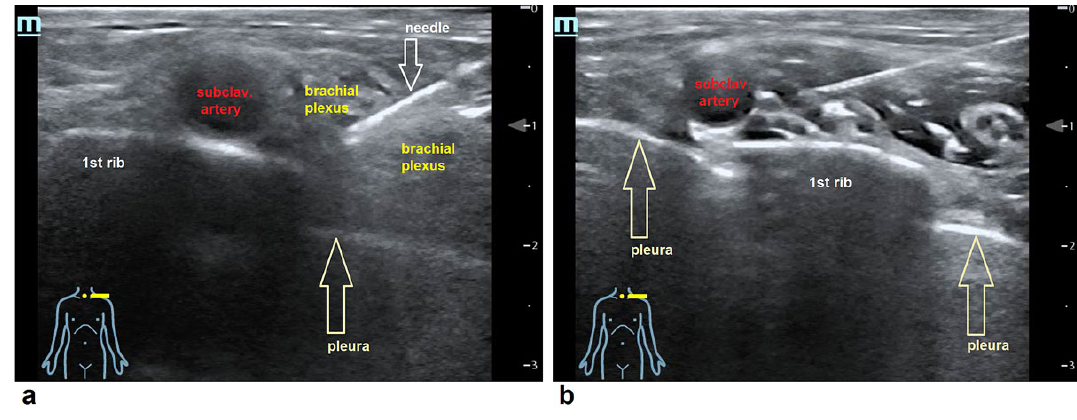
Figure 3: Ultrasound image of the brachial plexus. (a) Needle is placed between the nerves of the brachial plexus in the supraclavicular region above the first rib. (b) After injection of 15 ml local anaesthetic the nerves are surrounded with the fluid.